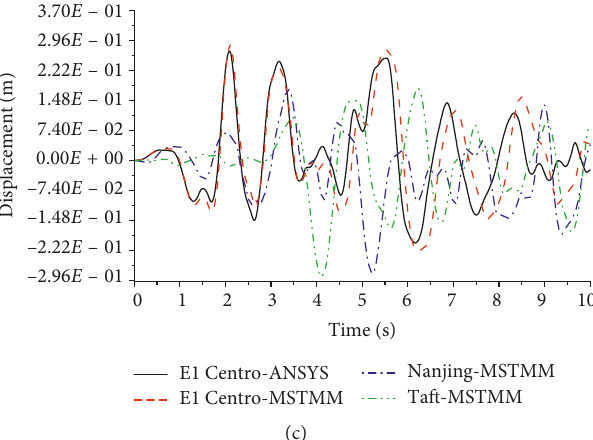
2 ). (a) 100mm,(b) 200mm, and